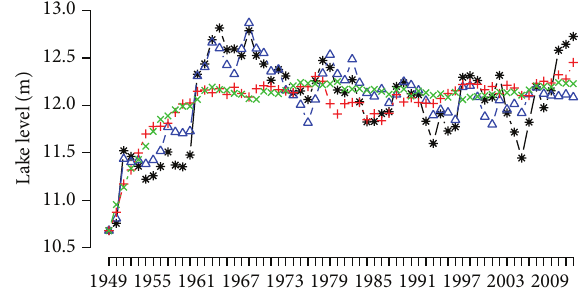
Figure 4: Results of using individual modes of annual precipitation variability in the water balance model for Lake Victoria. Levels mod- eled using the unfiltered CRU 3.21 dataset are in black (asterisks); levels modeled using precipitation accounted for by the first mode of annual variability are in blue (triangles); levels modeled using precipitation accounted for by the second mode of variability are in red (crosses),while levels modeled using precipitation accounted for by the third mode of variability are in green ( ×